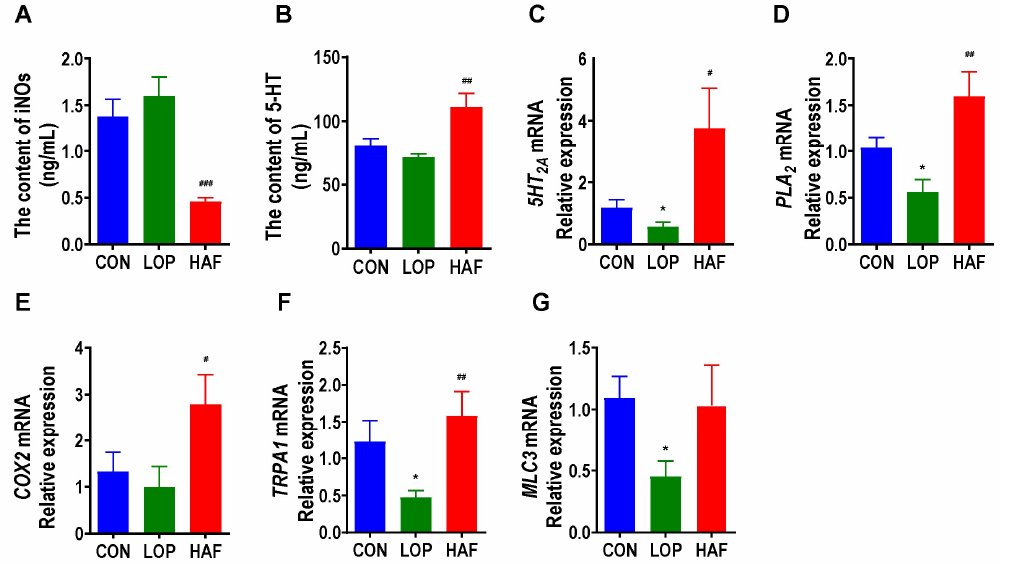
Figure 5. HAF increased the expression of gastrointestinal motility-related factors in the colon of STC mice. ( A , B ) Induced nitric oxide synthases (iNOS) and serotonin (5-HT) in serum. ( C – G ) The mRNA expression of serotonin 2 receptor ( 5-HT 2A ), phospholipase A2 ( PLA 2 ), cyclooxygenase-2 ( COX2 ), transient receptor potential cation channel, subfamily A, member 1 ( TRPA1 ), and Myosin light chain 3( MLC3 ) in the colon. The data are expressed as the means ± SEMs ( n = 8). *, compared with the CON group; #, compared with the LOP group. *, p < 0.05. #, p < 0.05; ##, p < 0.01; ###, p < 0.001.